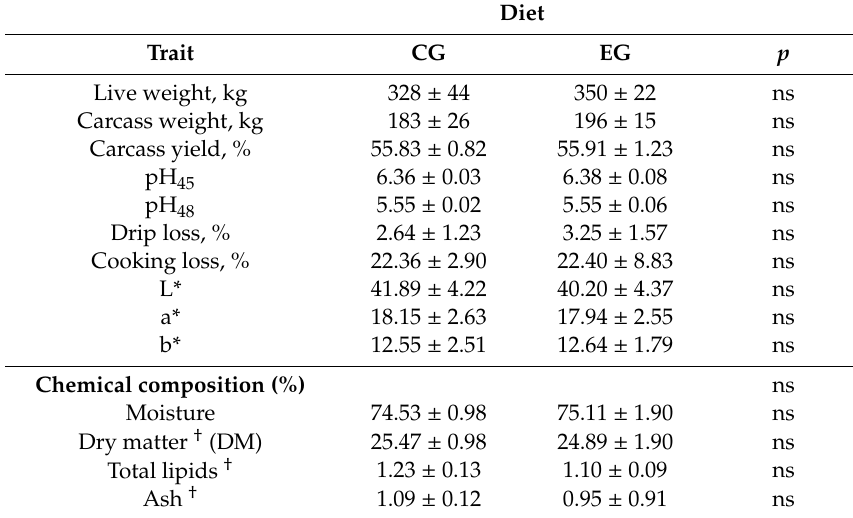
Table 3. Physical and chemical evaluations on meat samples obtained from calves fed a standard diet (CG) and calves fed a dietary supplementation of 10% dried grape pomace